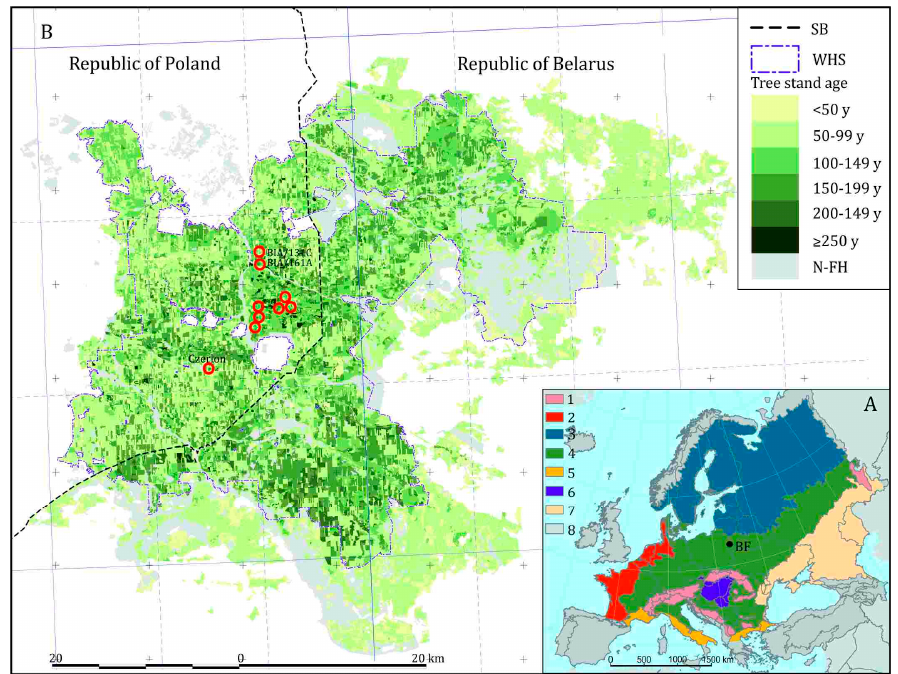
Figure 1. Biogeographic setting of Bia ł owie ż a Forest. ( A ) Bia ł owie ż a Forest (BF) on the background of the continental biogeographic regions of Europe [39]. Biogeographical regions: 1—Alpine; 2—